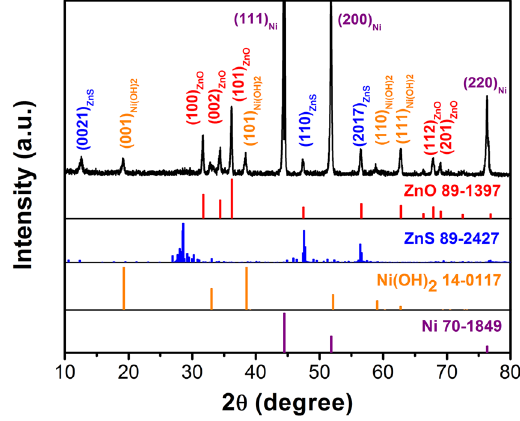
Figure 1. XRD patterns of the NZZN-4 mmol